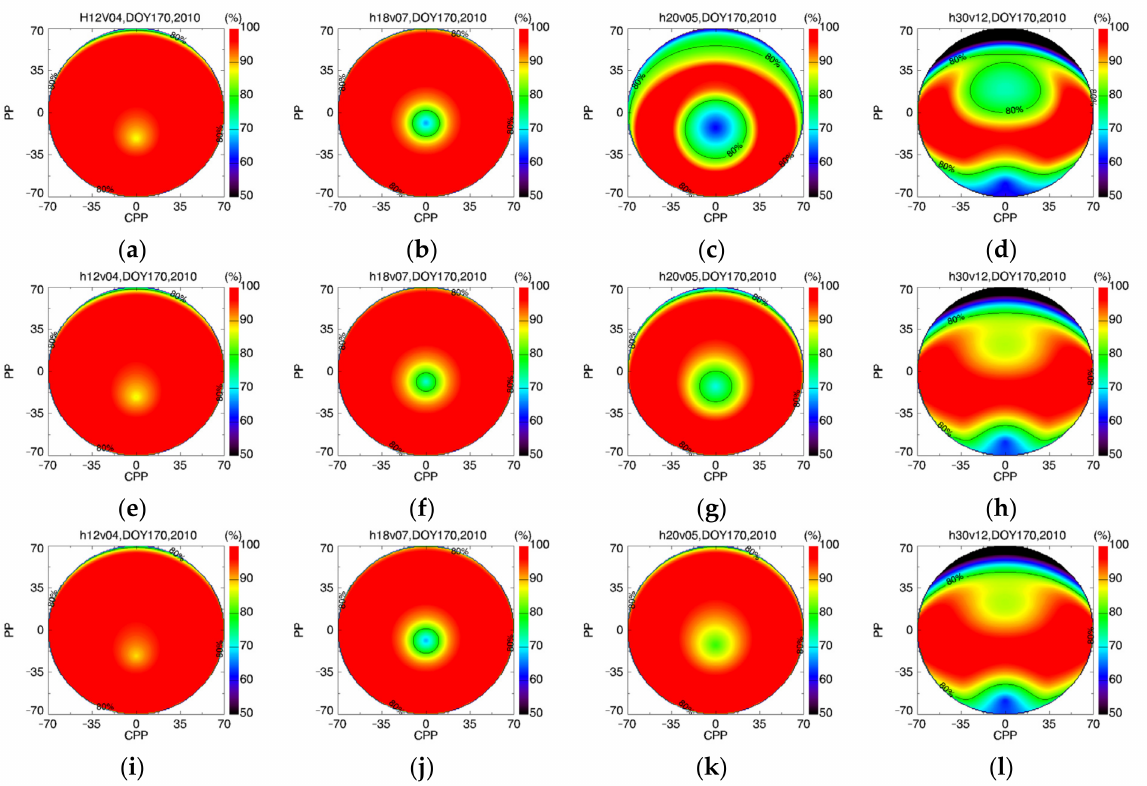
Figure 12. The P 0.02 in any direction over the entire viewing hemisphere for h12v04, h20v08, h18v07, and h30v12 on DOY 170, 2010: ( a – d ) the F -based albedo; ( e – h ) the F N -based albedo; and ( i – l ) the F L -based albedo. The radius and the polar angle represent the zenith angle and the azimuth angle,